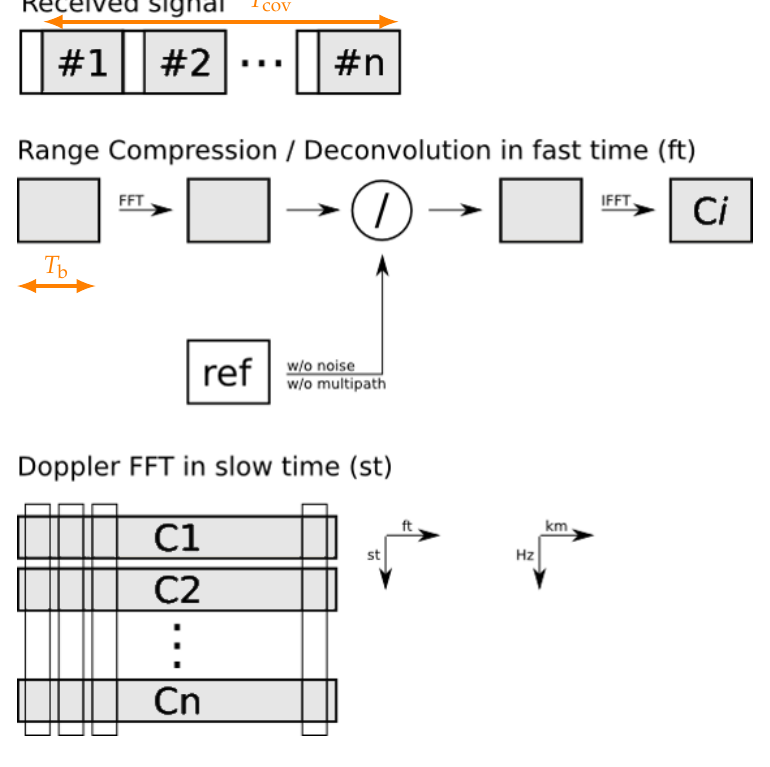
Figure 3. Batched range-Doppler processing principle to build a fast-time (ft) and slow-time (st) do- main and to speed-up the radar processing of a CP-OFDM waveform with a block duration T b = T u